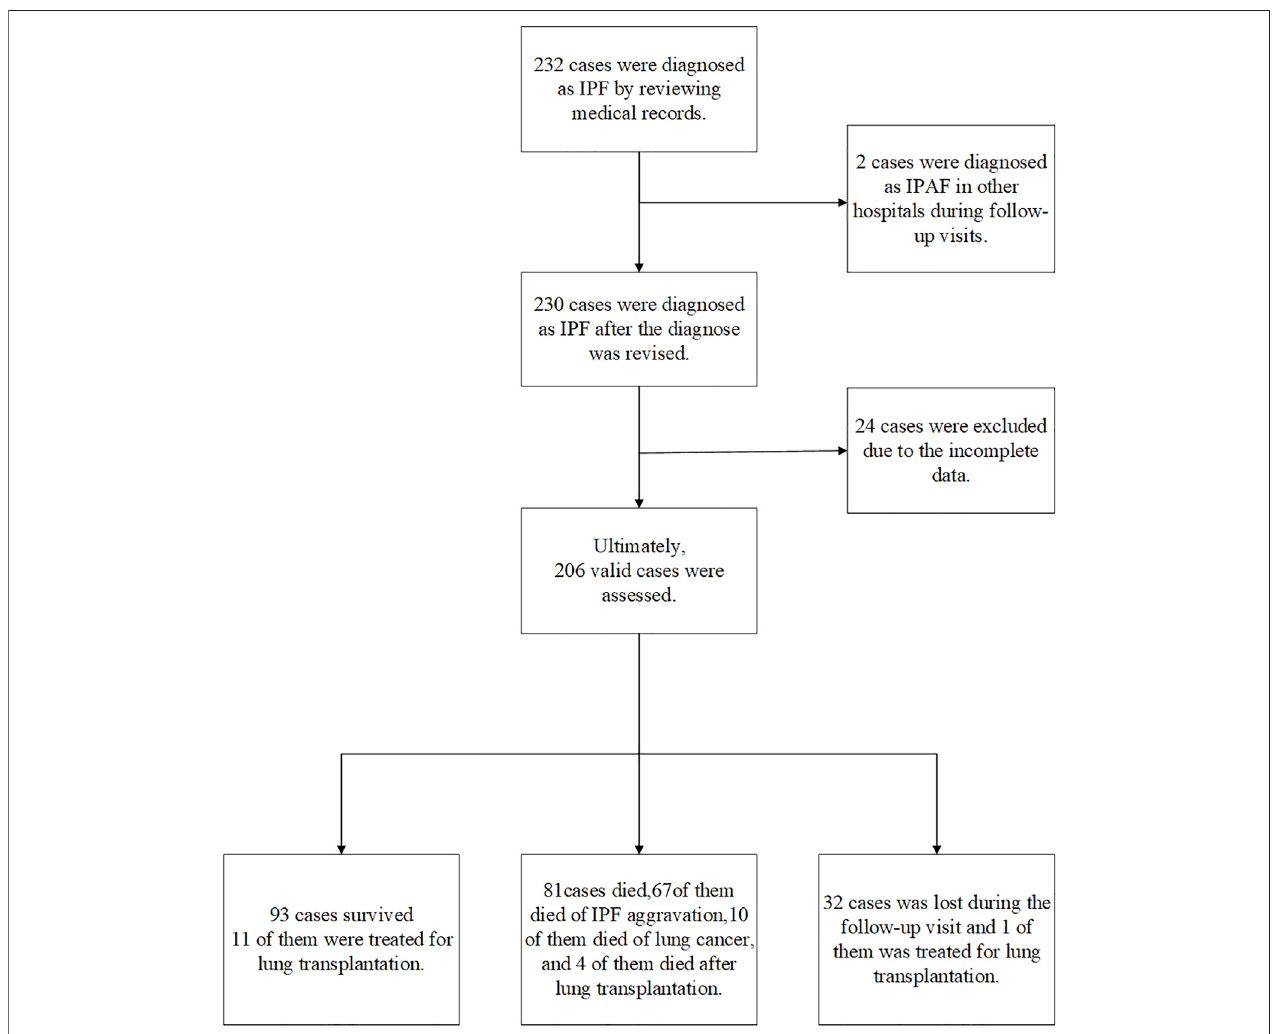
FIGURE1| Casescreeningprocess.Intotal,232caseswerediagnosedasIPFaccordingtothe2018IPFdiagnosisandtreatmentguidelines.Atotalof26patients were excluded, two patients were diagnosed as interstitial pneumonia with autoimmune features (IPAF) during follow-up; 24 patients had incomplete CT and lung functiondata.Finally,206caseswereincludedintheretrospectiveanalysis(including16casesoflungtransplantation):93survivingcases,including11lungtransplants; 81 deaths, out ofwhich 10 died from lung cancer, 67died from acute exacerbation of IPF, and 4died after lung transplantation; and 32 patients failed to follow up, including one failed to follow up after lung transplantation.